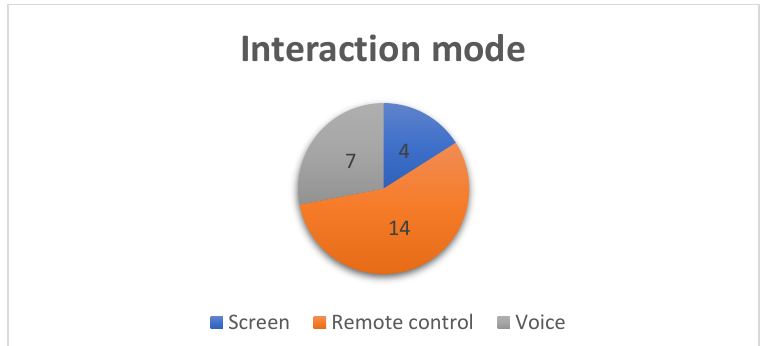
Figure 7. Average test duration: 10 – 11 min .